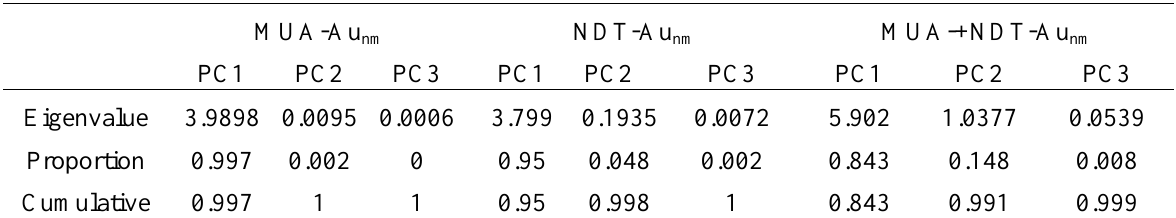
Table 7. Eigenanalysis of correlation matrix for a three-candidate based sensor array